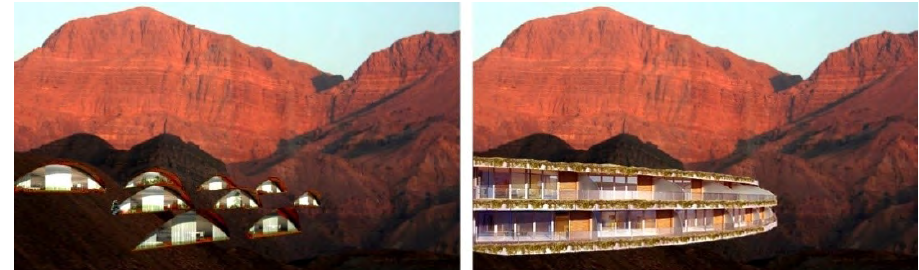
Figure 7. The detached urban form is recommended for gathering units atnew communities of Earth-sheltered buildings.